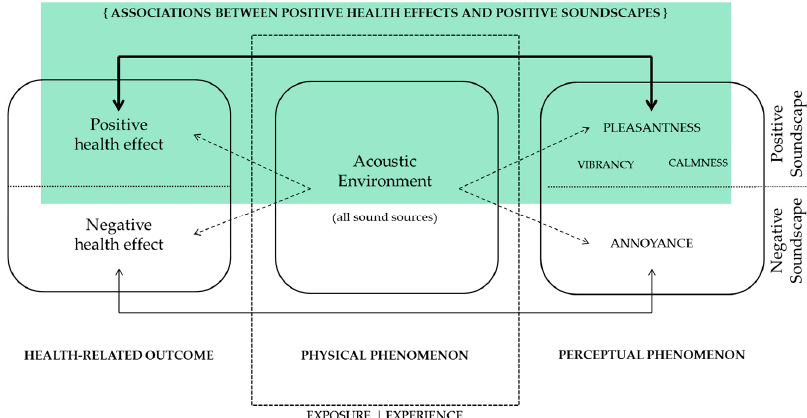
Figure 1. Schematic representation of the theoretical framework underpinning the systematic review: The inclusion criteria were defined to detect studies that established clear associations positive soundscapes and positive health-related effects (area highlighted in green), instead of negative soundscapes and negative health effects (bottom part of the figure), and to dismiss those focusing only on either the perceptual outcome or the health-related outcome (dashed arrows).